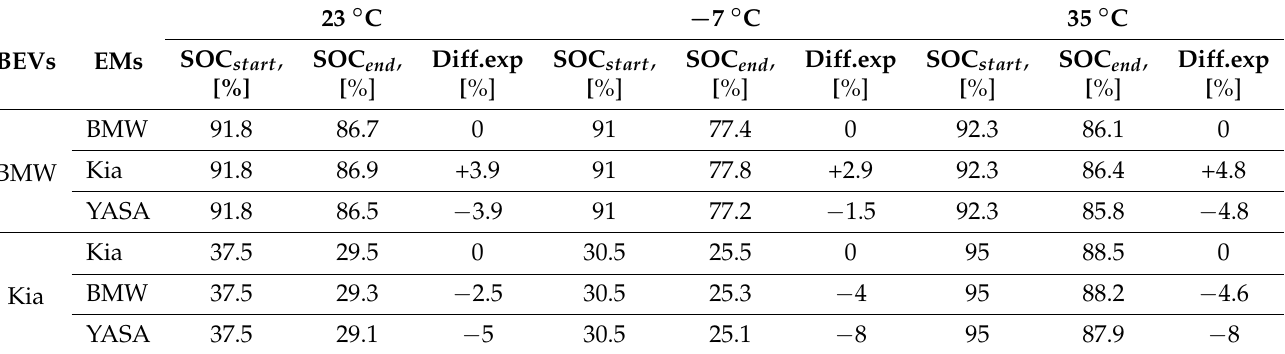
Figure 11. Variation of battery SOC during the UDDS driving cycle for different EMs installed on Kia Soul: ( a ) with re-scaled characteristics of EMs; ( b ) with original characteristics of EMs; ( c ) vehicle speed profile variation over the UDDS cycle; ( d ) EM torque variation over the UDDS cycle. Table 4. SOC results for re-scaled EMs at different ambient